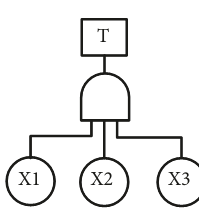
Figure 2: AND gate operator with three bottom